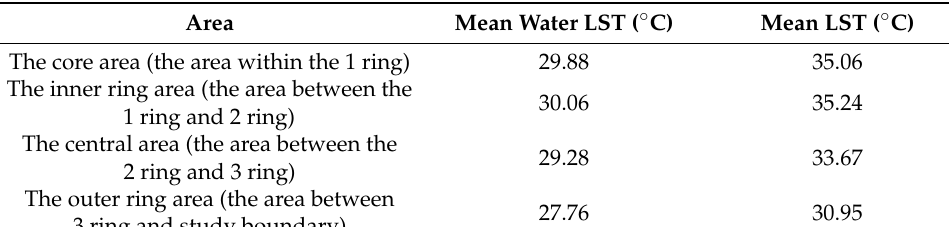
Table 3. Land surface temperature for each district.